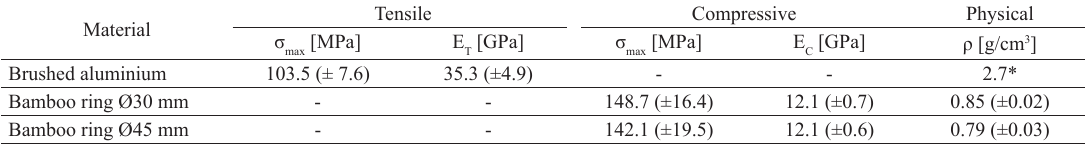
Table 2. Mechanical and physical results of the panel constituents.